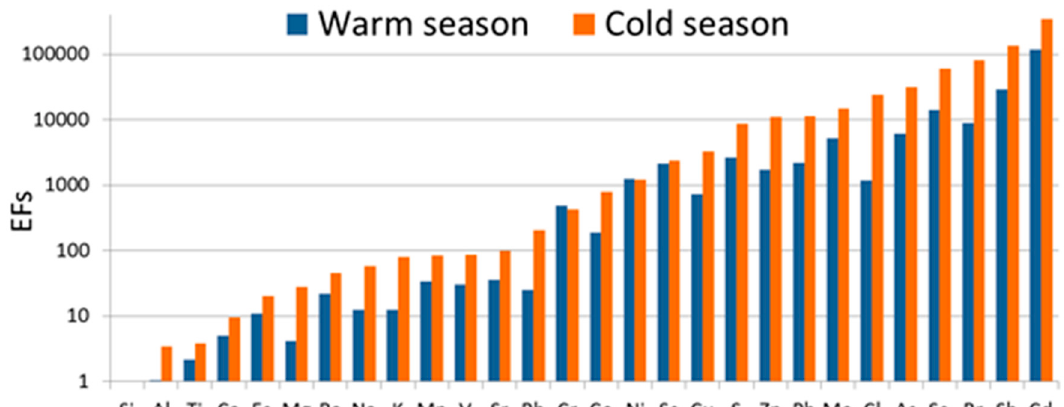
Figure 2. The enrichment factors (EF) for the elements in PM 2.5 averaged for the cold/heating season and the warm/non-heating season